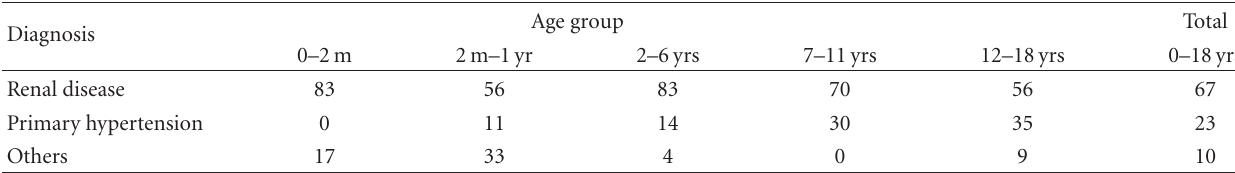
Table 1: Causes of hypertension in children by age group (percentage).